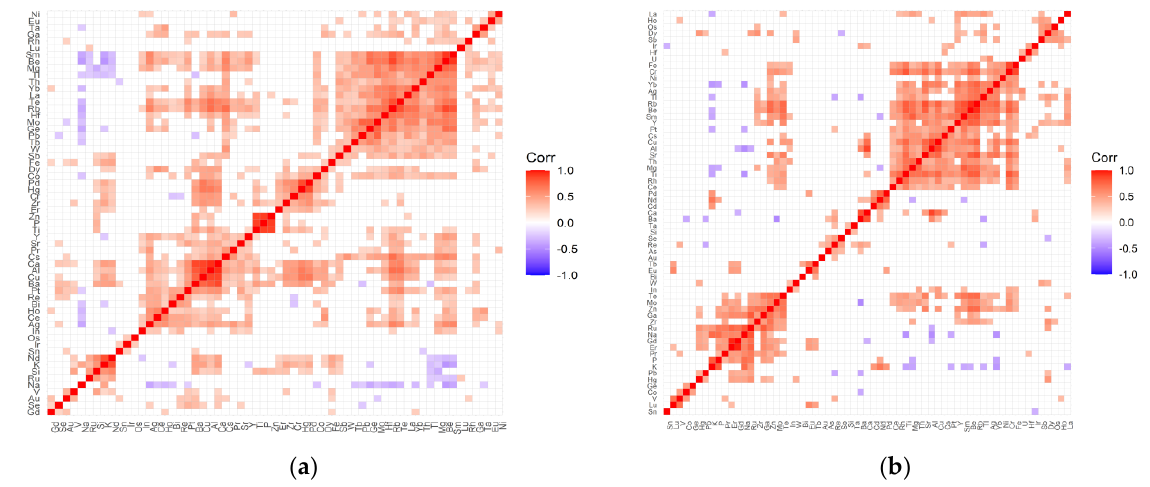
Figure 4. Correlation matrix for the control ( a ) and test ( b ) groups representing patients with cataract and coexisting dia-